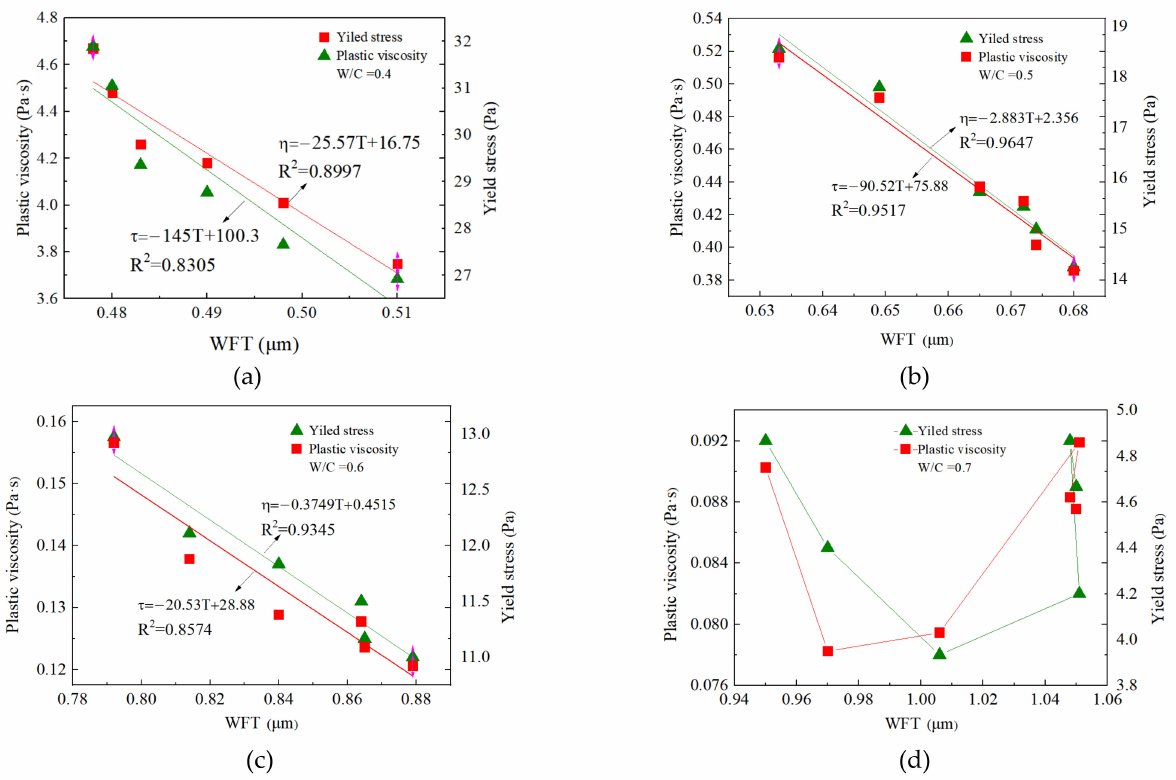
Figure 11. WFT vs. yield stress and plastic viscosity. ( a ) w/c = 0.4; ( b ) w/c = 0.5; ( c ) w/c = 0.6 and ( d ) w/c =